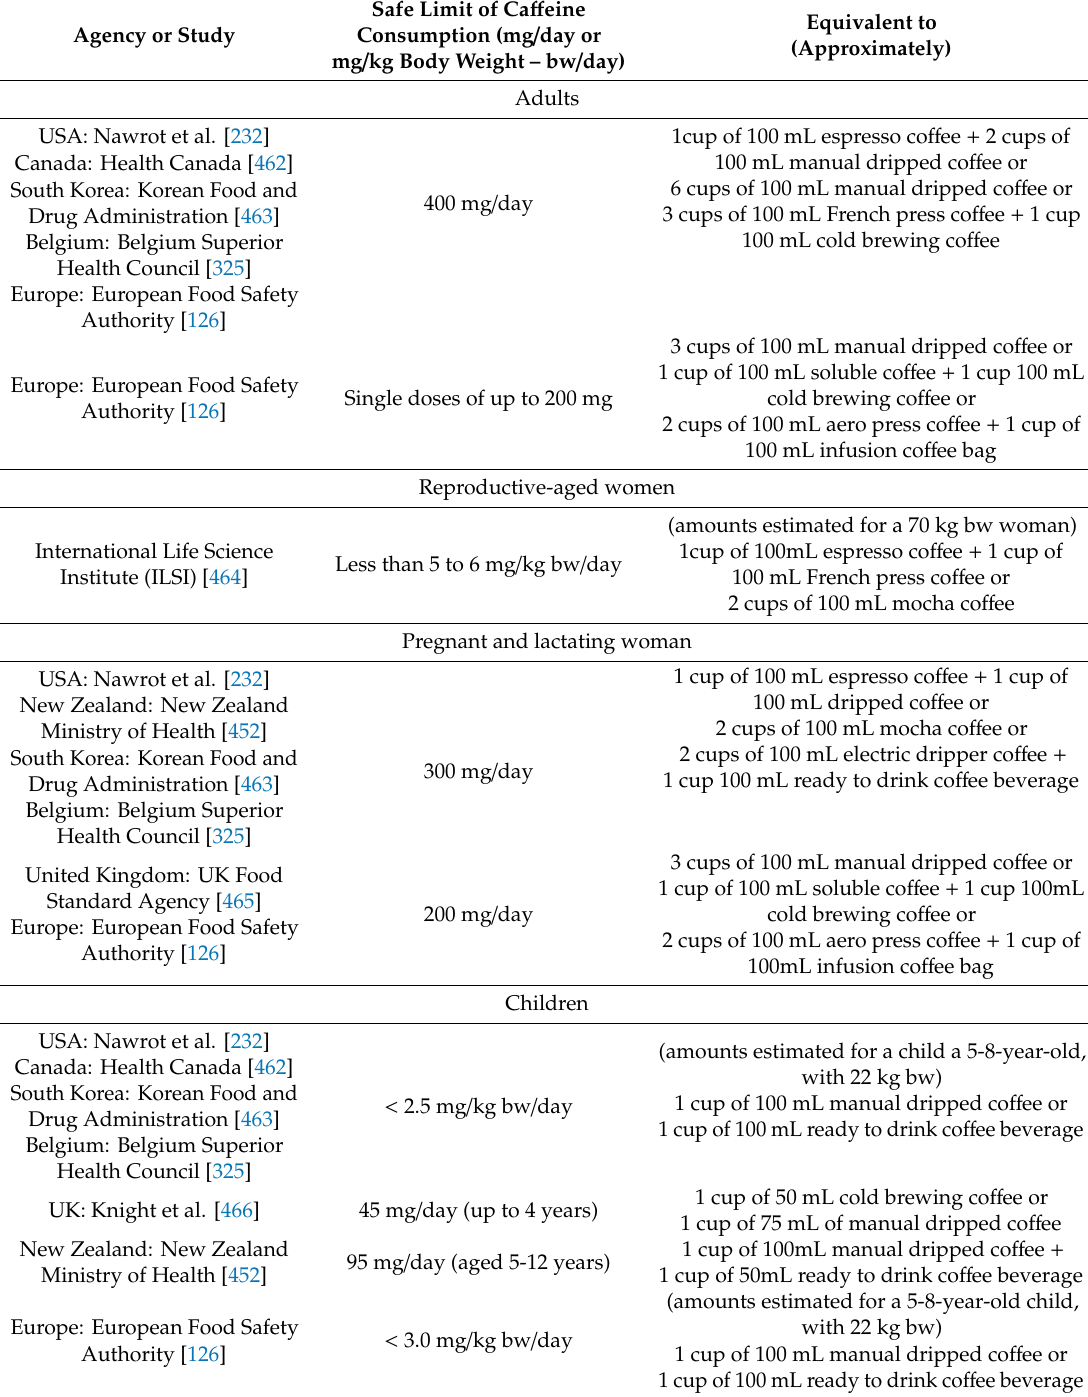
Table 5. Ca ff eine intake safety limit for di ff erent age groups recommended by studies and regulatory agencies around the